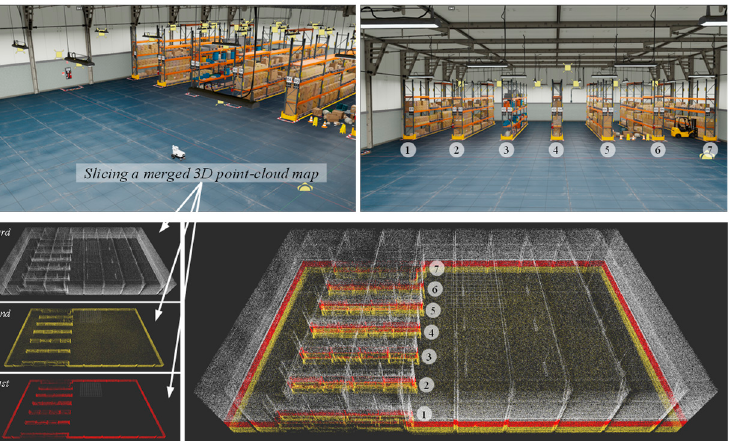
Figure 3. ( Top ) virtual warehouse environment, including two assets of full_warehouse.usd and Carter_v2.usd with proper lighting control in RTX real-time rendering mode, ( Bottom ) example of multi-layer slicing of a merged 3D point-cloud map obtained from LIO-SAM and dual 3D lidar.